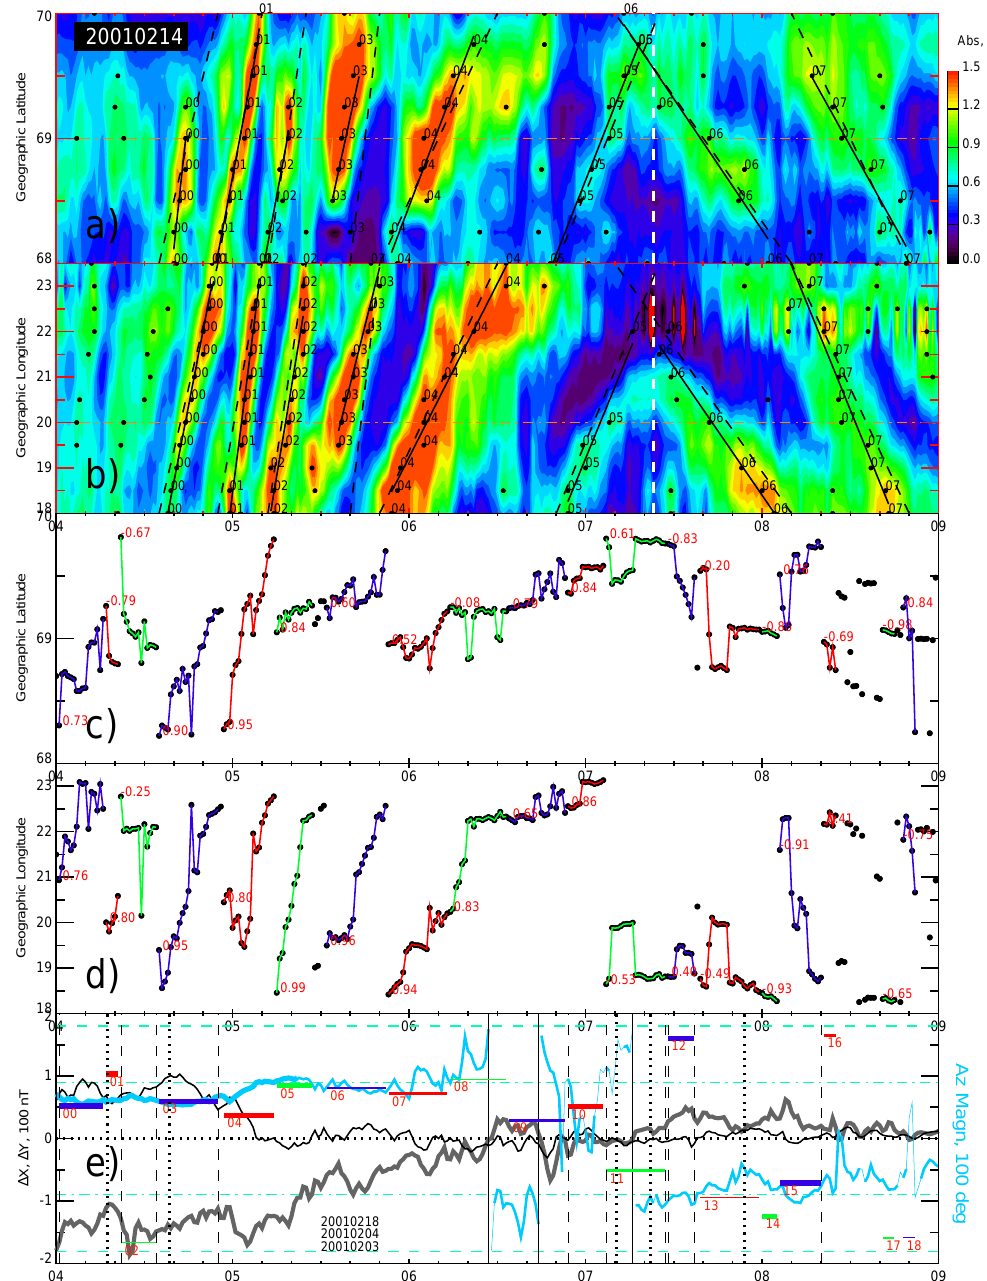
Fig. 2. The IRIS absorption keograms for 14 February 2001, 04:00–09:00 UT, at 1-min resolution for (a) 20 ◦ E and (b) 69 ◦ N. The keogram geographic longitude and latitude are indicated in (b) and (a), respectively, by the dash-dotted orange lines. The scale for the absorption is indicated on the right of panel (a). The black dots show the local maxima in time for the absorption. The dashed black lines represent the initial guesses for the absorption patch movements, while the solid lines denote the best fits to all maxima located within 10min of the initial guesses. The maxima for each patch are marked by digits showing the patch number (from 00 to 07). The vertical dashed white line shows the reversal time of the patch motion direction (from eastward to westward). Panels (c) and (d) show the location of the absorption maxima identified in Fig. 1 within the IRIS field of view. The maxima for each individual absorption patch are connected by the coloured lines with the correlation coefficients for each patch shown by red digits nearby. Panel (e) shows the 1X ( 1Y ) component of magnetic perturbations from KIL station at 1-min resolution by the heavy (light) black line. The days used for QDC calculations are indicated at the bottom of panel (e). The blue line represents the azimuth of electrojet plasma flow as inferred from the magnetometer data. The thickness of the line corresponds to the magnitude of horizontal perturbations. The solid vertical lines denote the reversals in azimuth sign. Also shown in panel (e) by coloured horizontal lines are the azimuths of the absorption patch motion. The patch number from Fig. 1 is shown at the bottom of each